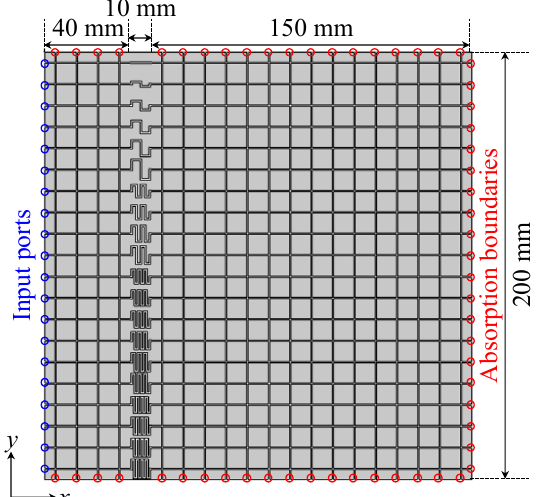
Figure 8. Configuration for full-wave simulations of the designed acoustic metasurface. The acoustic metasurface of 200 × 10 mm 2 in Figure 4 is sandwiched between two background media whose sizes are 200 × 40 and 200 × 150 mm 2 . The background media are composed of the structure of #5 in Figure 2. Twenty input ports are set to the left-hand side boundaries of acoustic waveguides, and other boundaries are chosen as absorption boundaries.